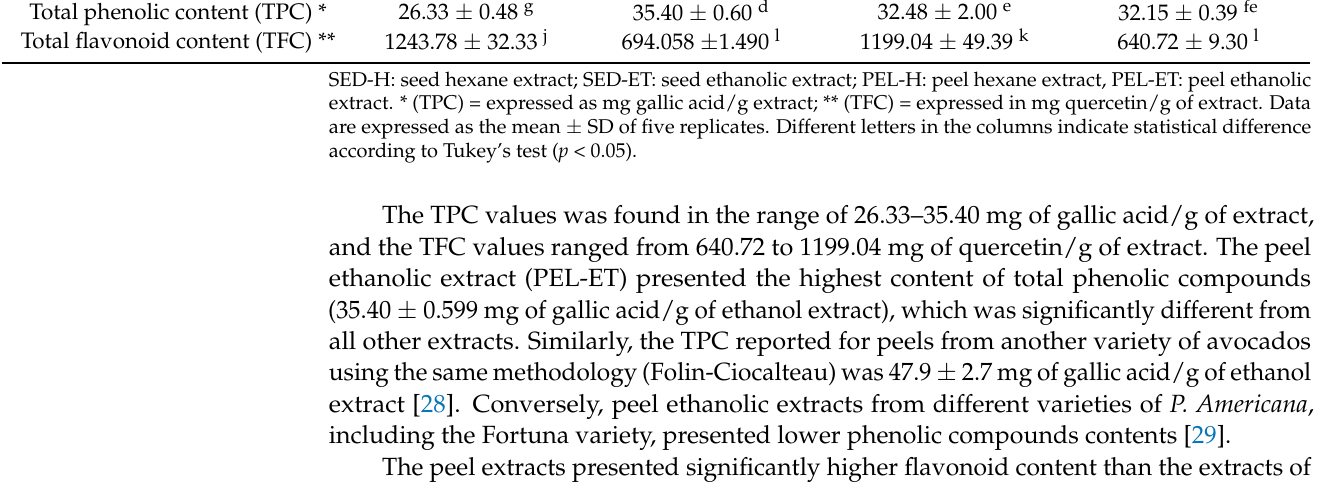
Table 3. Concentrations of phenols and flavonoids in different extracts of avocado peels and seeds. Assays PEL-H PEL-ET Total phenolic content (TPC)